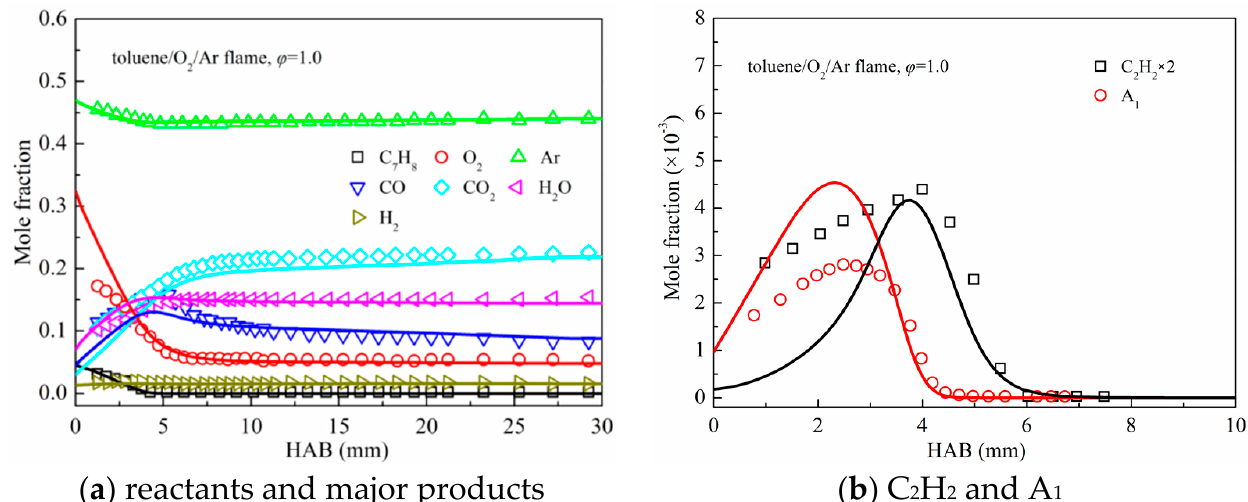
Figure 7. Measured [45] (symbols) and predicted (lines) species pro fi les in premixed toluene fl ame.